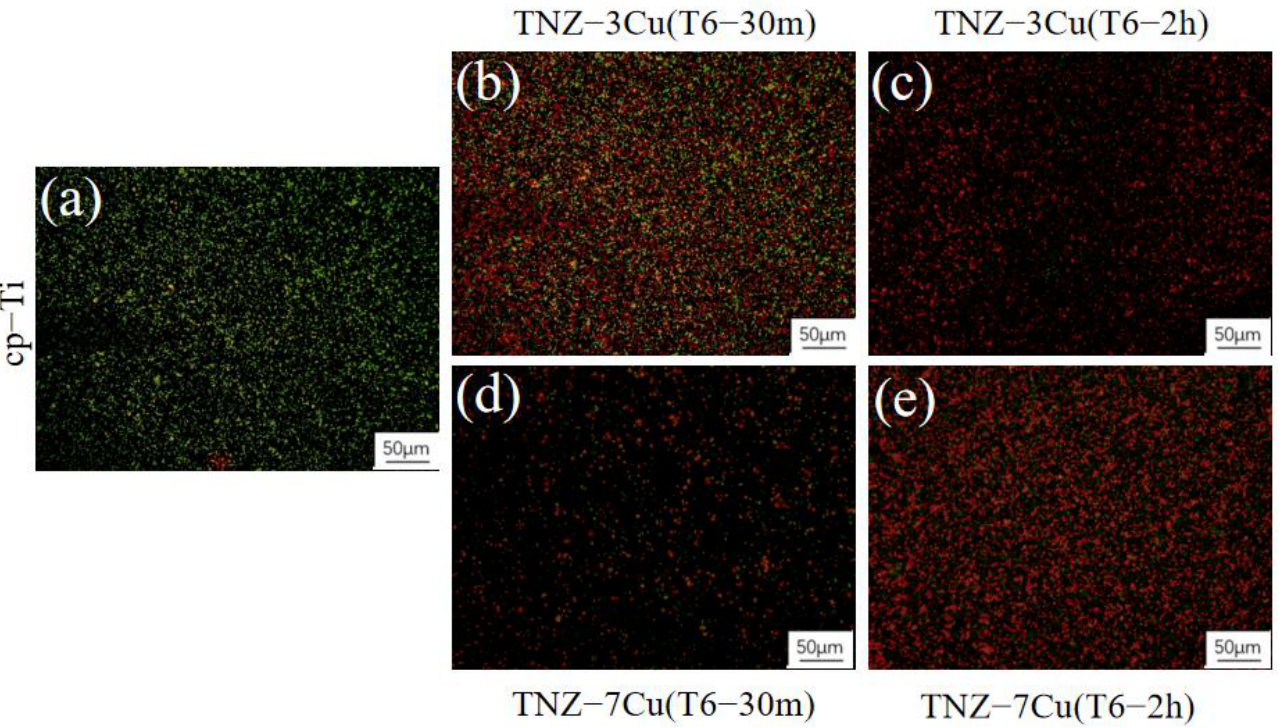
Figure 11. Live/Dead staining of S. aureus inoculated on the different samples for 24 h. ( a ) cp-Ti; ( b ) TNZ-3Cu(T6-30m); ( c ) TNZ-3Cu(T6-2h); ( d )TNZ-7Cu(T6-30m); ( e ) TNZ-7Cu(T6-2h).